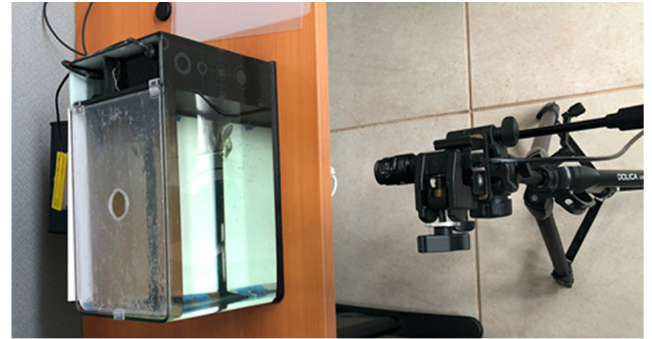
Figure 2. First system configuration.